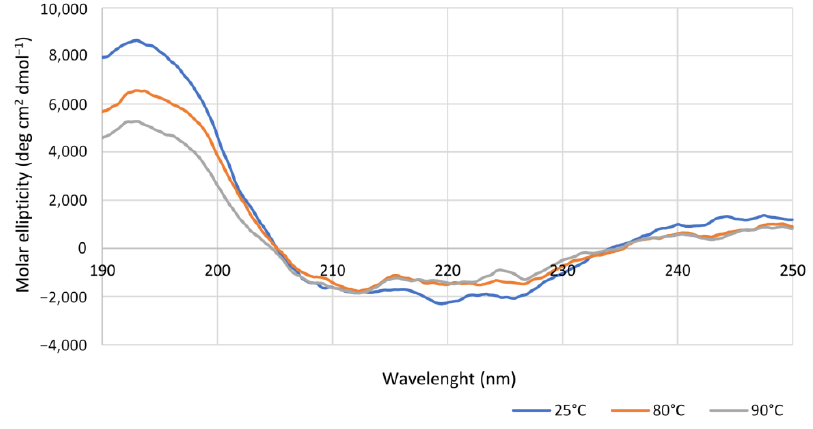
Figure 4. Overlapping of spectra obtained through Circular Dichroism spectroscopic analysis of pu- rified Is2-SDR at 25 °C, 80 °C, and 90 °C (see materials and methods for experimental details). In order to evaluate the influence of water-miscible organic solvents on Is2-SDR activity and stability, the purified enzyme solution was properly diluted with PB, pH 7.0, then selected solvents, i.e., methanol (MeOH), ethanol (EtOH), dimethyl sulfoxide (DMSO), and acetonitrile (ACN), were added at concentrations of 5, 10, and 20% ( v / v ). After 1, 3, 5, and 24 h of incubation, the residual enzymatic activity was determined by spectrophotometric assays (Figure 5a). An overall good tolerance was observed and, in some cases, an increase in activity in the first hours of exposure, particularly in the case of 5% ( v / v ) MeOH, 10% ( v / v ) EtOH, and 10% ( v / v ) ACN, was observed. The best results in terms of stability at 24 h (about 50% residual activity) were achieved in the presence of 20% ( v / v ) MeOH, 20% ( v / v ) EtOH, and 10 or 20% ( v / v ) ACN.